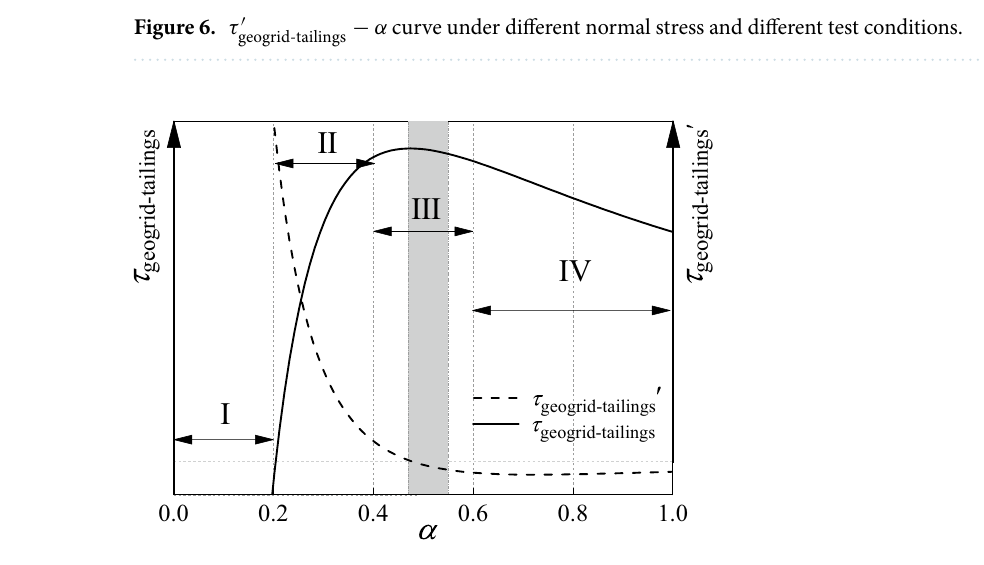
Figure 7. The schematic diagram of effect change of geogrid reinforced